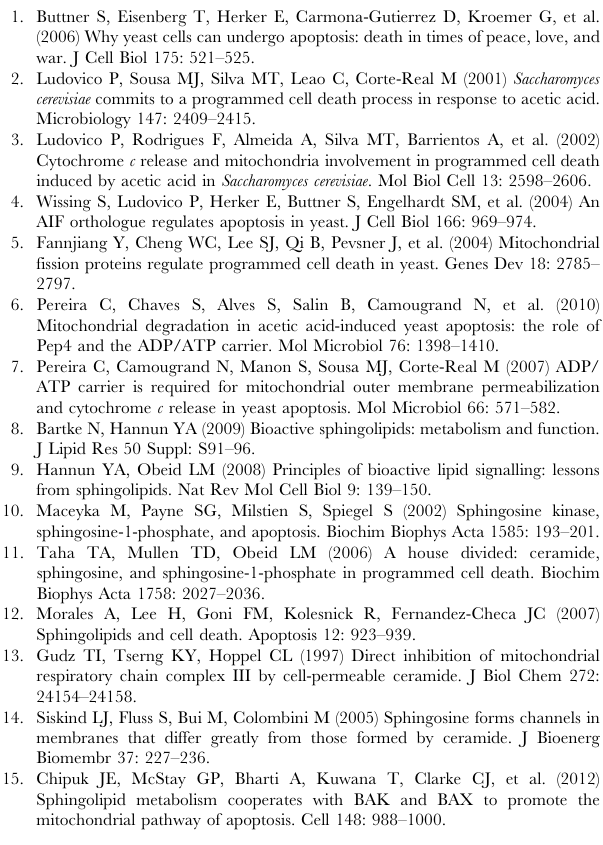
Figure S1 Protein oxidation in S. cerevisiae CG379 (wild-type), lag1 D and isc1 D strains before ( 2 ) and after ( + ) exposure to 180 mM acetic acid, pH 3.0, for 200